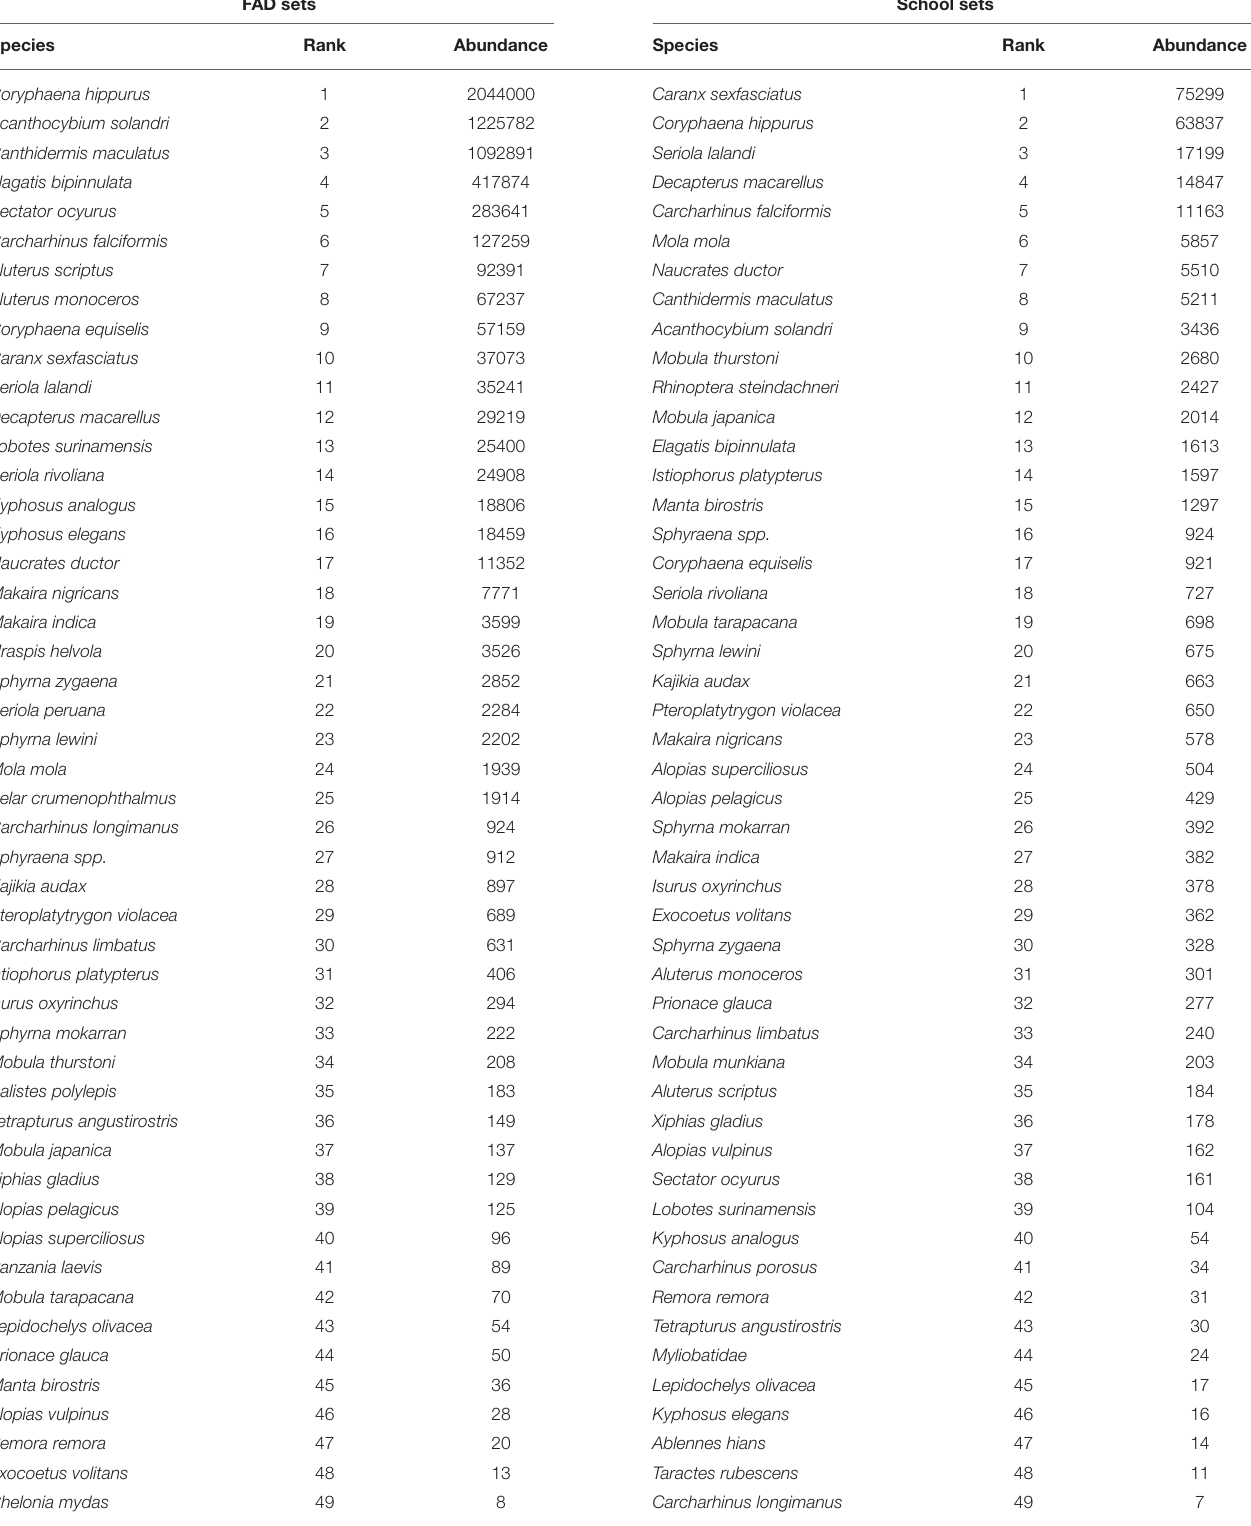
TABLE 2 | Species abundance in FAD and School